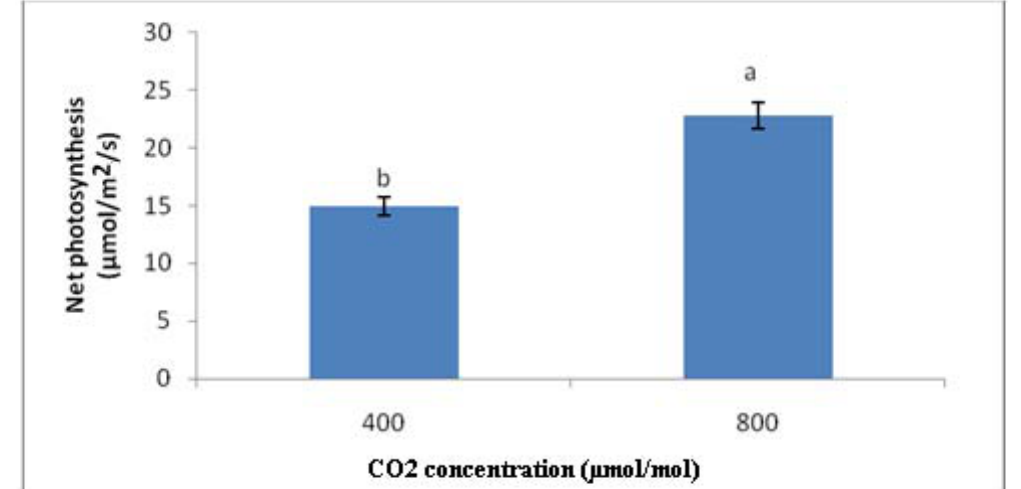
Figure 2. Effects of different CO non-irradiated plants of C.asiatica ; n = 4 (CO CO 2